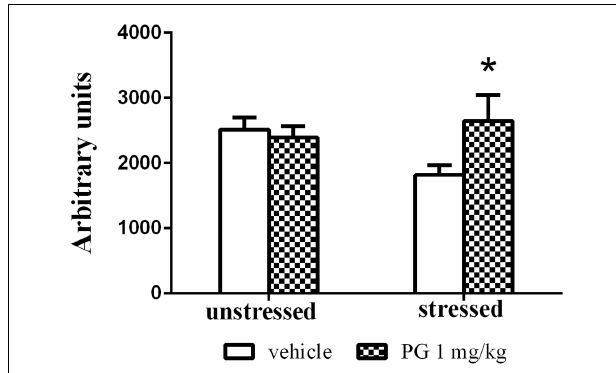
FIGURE 4 | Group-housed mice repeatedly stressed by defeat on four agonistic interactions (7days apart) with aggressive singly housed partners exhibited depressed locomotor activity in the open field .This effect was disinhibited by treatment with PG at the dose of 1mg/kg.There was no difference in unstressed animals between two treatment groups in the open-field activity. All values represent group means ± SEM. * p < 0.05 compared to the stressed vehicle treated animals.